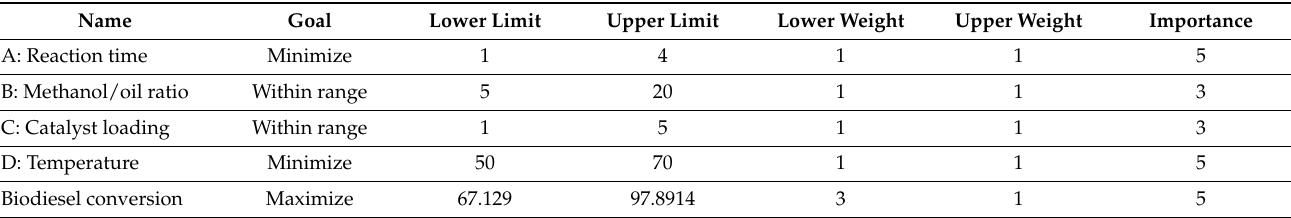
Table 7. Optimization constraints.